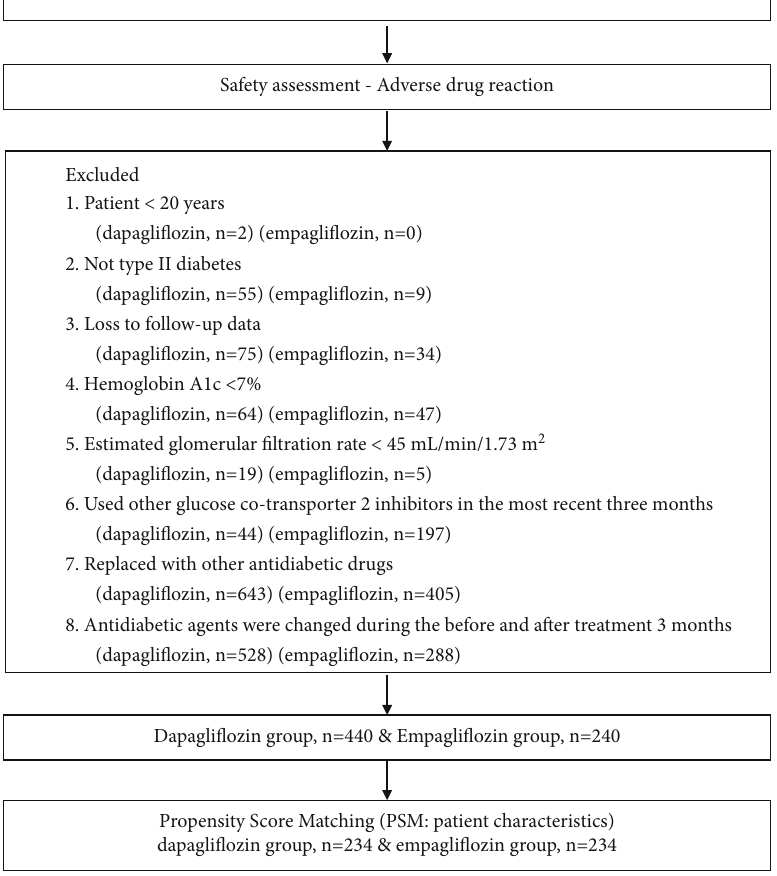
Figure 1: Flow chat of patient